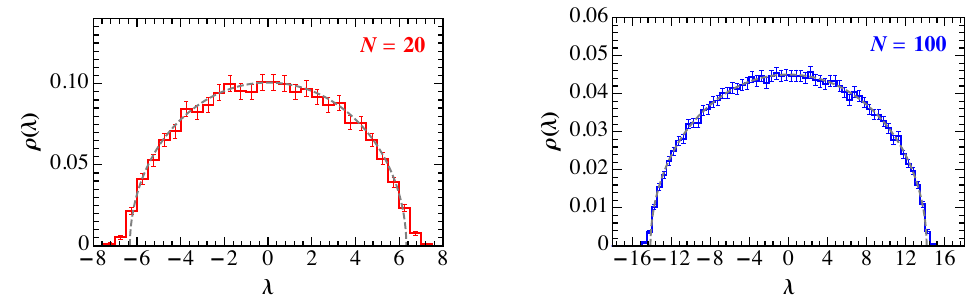
Figure 3. Left: the spectral density of a 20 (cid:2) 20 matrix (red) drawn from the Gaussian Orthogonal Ensemble and the Wigner semicircle (gray). Right: the spectral density of a 100 (cid:2) 100 matrix (blue) drawn from the Gaussian Orthogonal Ensemble and the Wigner semicircle